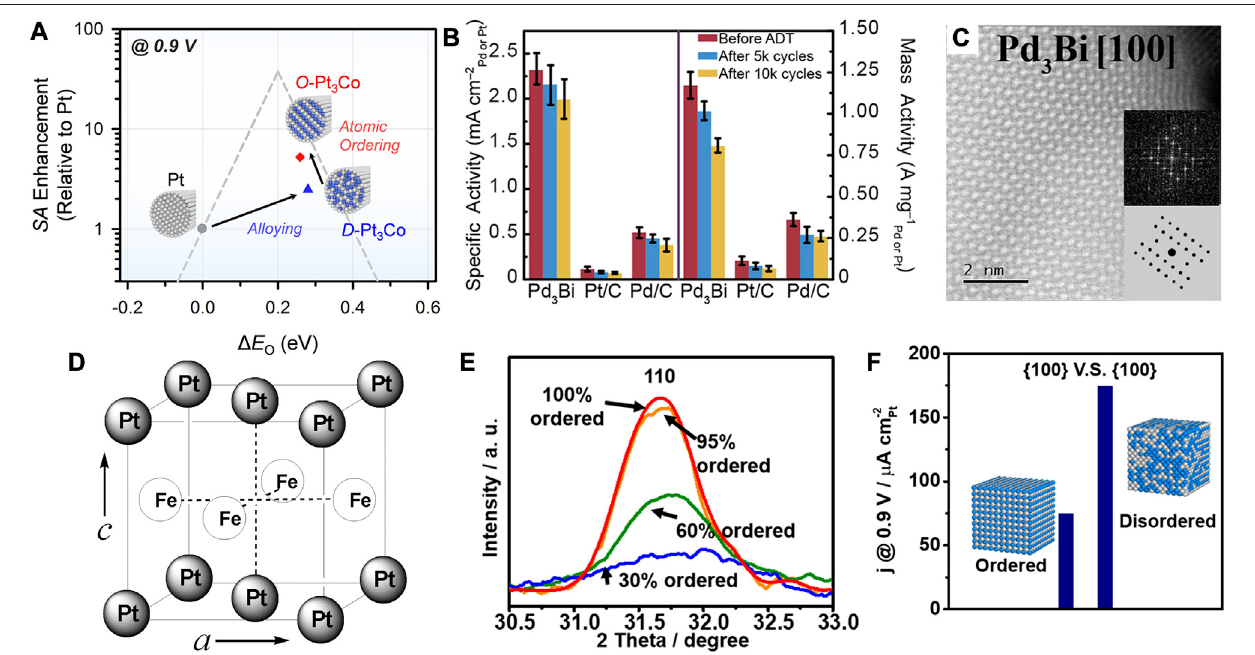
FIGURE9|(A) VolcanicrelationshipbetweenORRactivityandOadsorptionenergyofcatalysts. (B) ComparisonofORRactivityin0.1 MKOH. (C) HRTEMimage of Pd 3 Bi (100) crystallographic facet. (D) Ordered fct structure of PtFe. (E) Comparison of diffraction intensity of (110) diffraction peaks. (F) Comparison of Pt 3 Sn ORR activitybetween60and95%DOs.Theillustrationisaschematicdiagramoforderedandrandomalloys. (A – C) Reproducedwithpermission(Kimetal.,2019b;Sunetal., 2019).Copyright 2019, American Chemical Society. (D) Reproduced with permission (Kim et al., 2010). Copyright 2010, American Chemical Society.